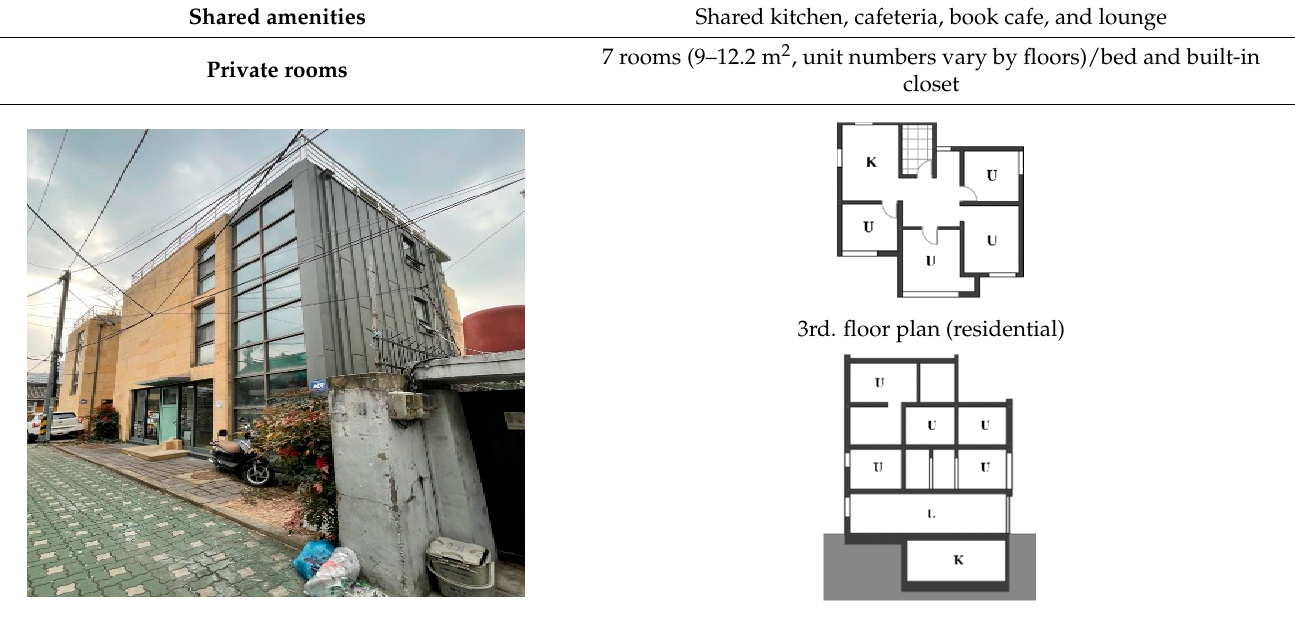
Table 4. Tongui-dong house [22].